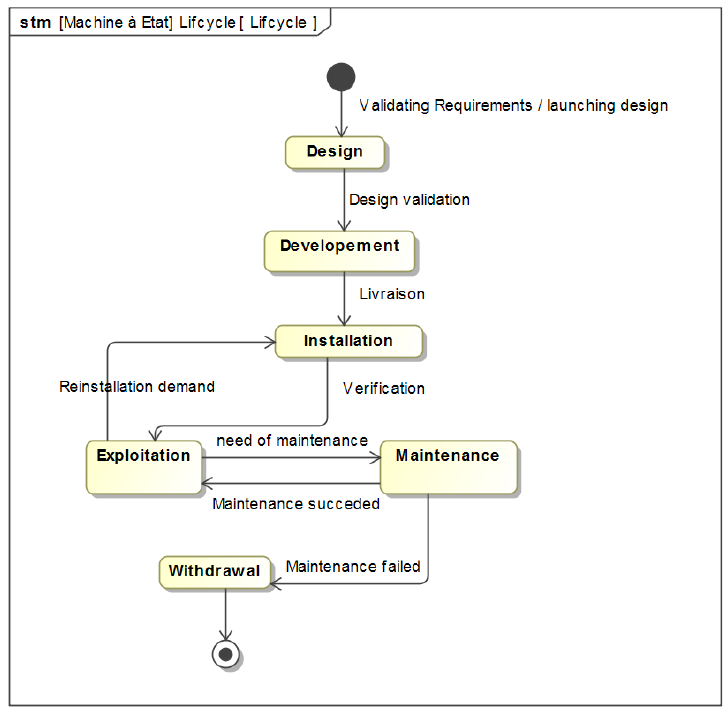
Table 1. Classification of the stakeholders ’ needs.